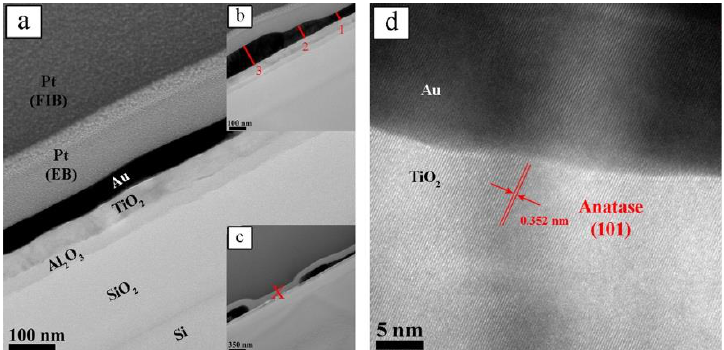
Figure 5. TEM cross sectional images of Au-dTiO annealed sample (annealed at 450 °C for 6 h): ( a ) continuous and uniform gold film; ( b ) thickness variation at specific locations; ( c ) discontinuity in the gold film; and ( d ) HRTEM image of the TiO 2 /Au interface. Reproduced from [71] . with permission from Elsevier, 2018.